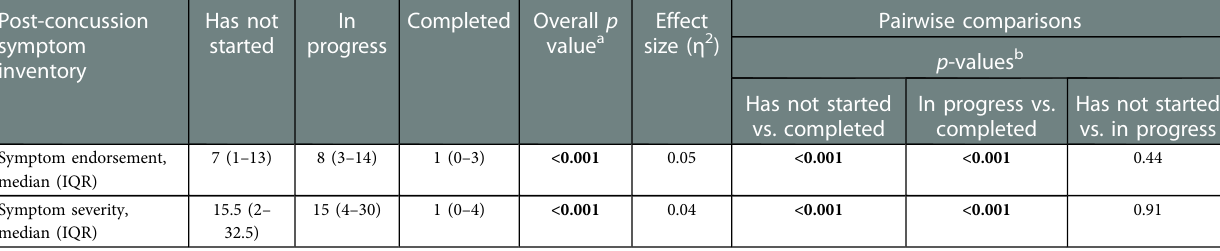
TABLE 3 Symptom endorsement and severity of patients at follow-up by self-reported progress with the home visio-vestibular program and post-hoc pairwise comparisons. Post-concussion symptom inventory